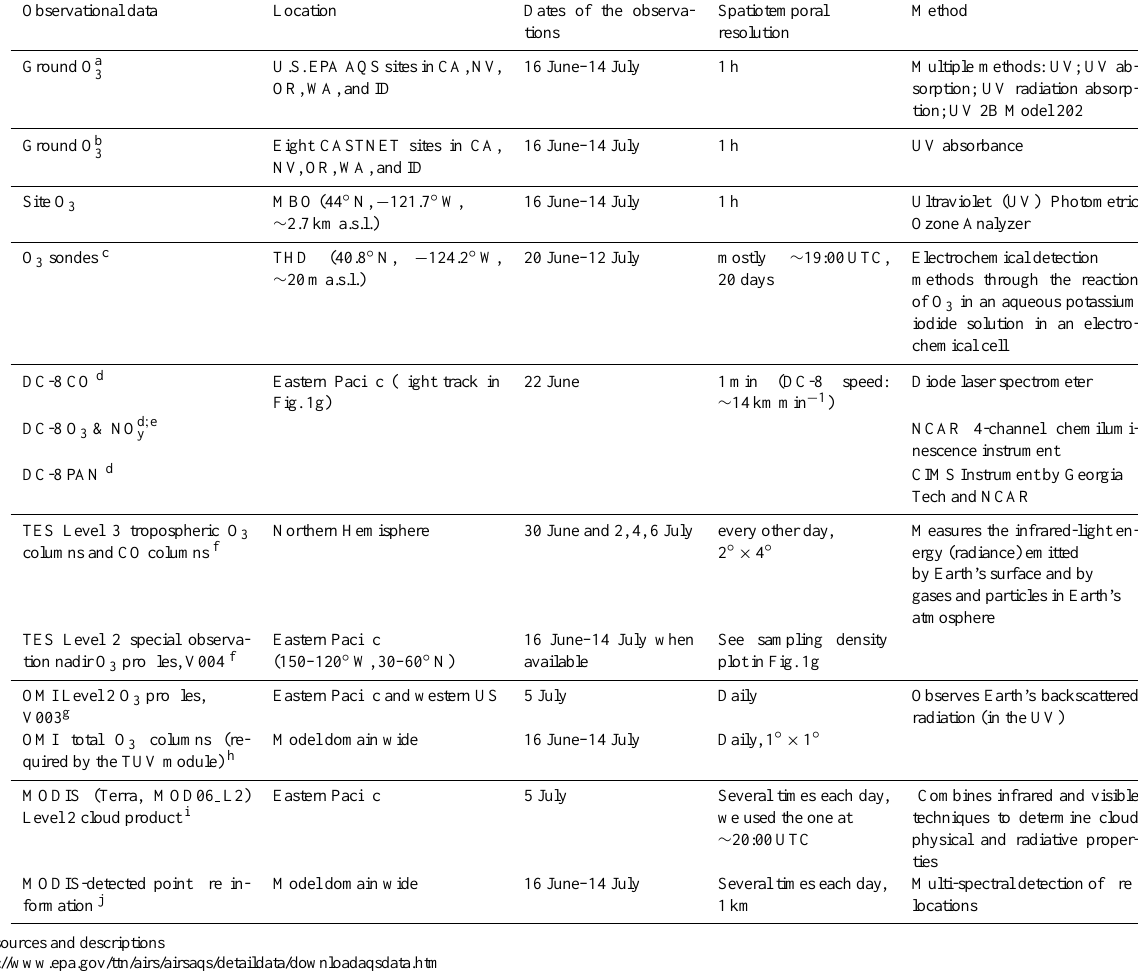
Table 1. Description of observational datasets used in this